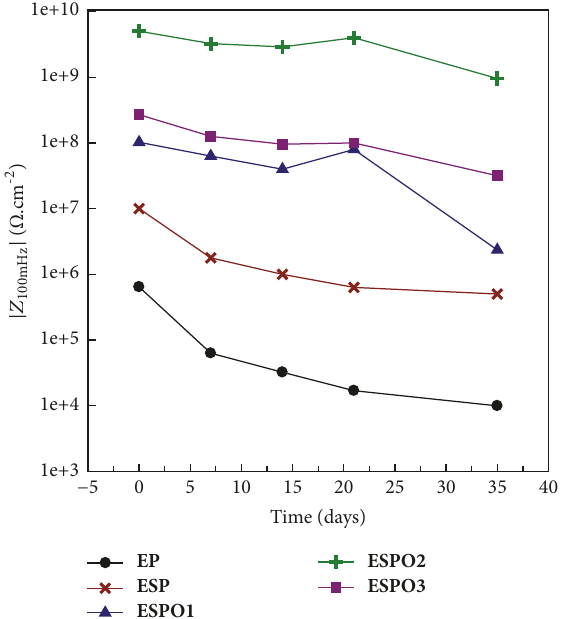
Figure 10: | Z | 100 mHz versus immersion time in 3% NaCl solution of